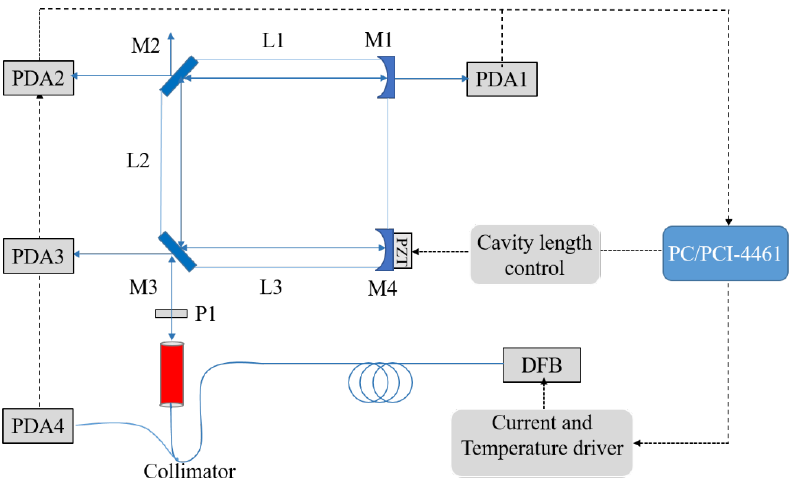
Figure 1. Experimental device structure diagram of U-shaped CEAS. M1–M4: mirrors; DFB: distributed feedback semiconductor laser; P1: line polarizer; PDA: photodetector; PZT: piezoelectric ceramic transducer.